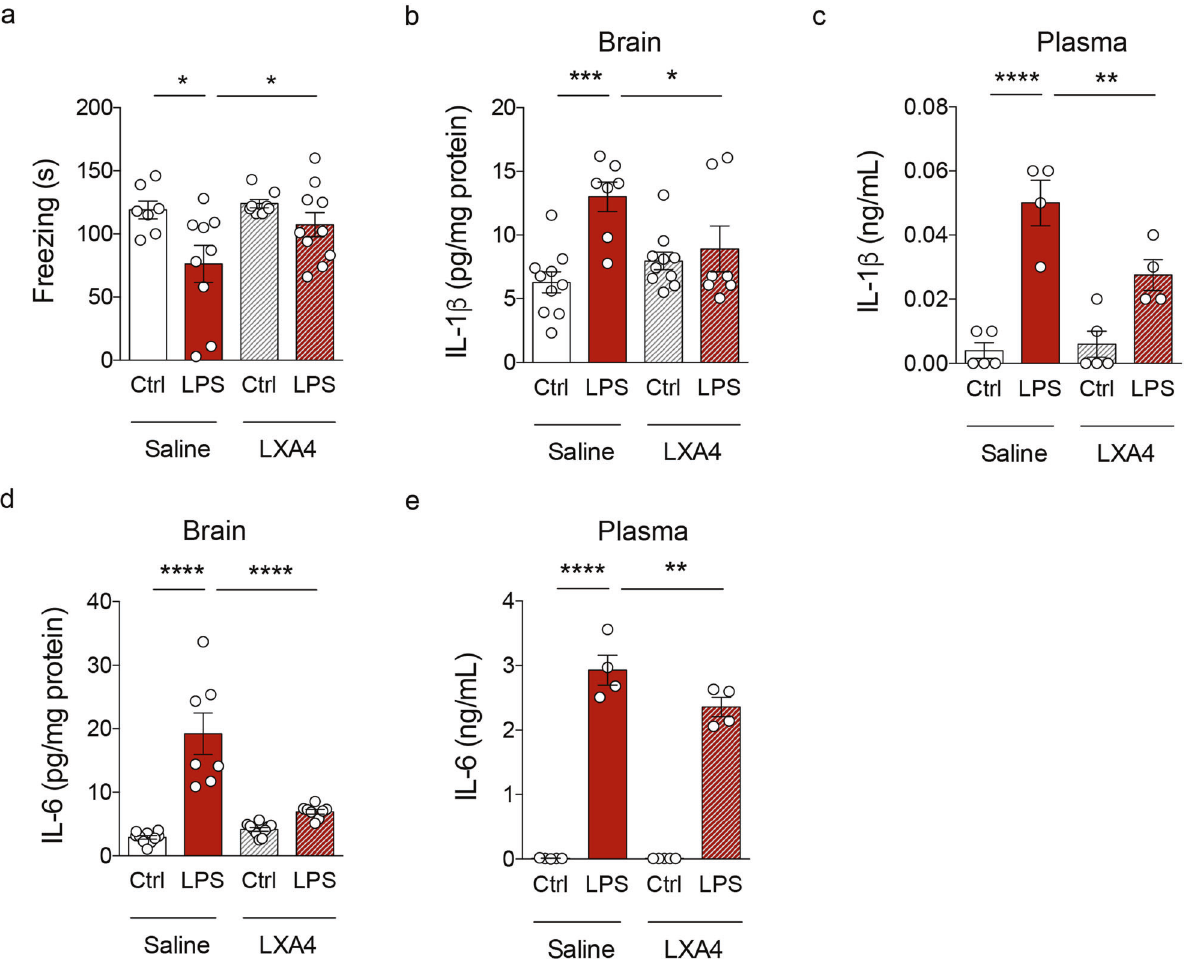
Fig. 3 LXA4 attenuates in fl ammation-induced memory failure and cytokine production in mice. a Freezing (seconds) of control or LPS- injected mice (0.3 mg/kg) treated with vehicle or 1 pmol LXA4 (i.c.v) in the contextual fear conditioning task. b – e Brain and plasma levels of IL-1 β ( b , c ) or IL-6 ( d , e ) in control or LPS-injected mice (0.3 mg/kg; i.p.) treated with vehicle or 1 pmol LXA4 (i.c.v). Two-tailed unpaired two-way ANOVA followed by Holm – Š idák post hoc test (* p < 0.05; ** p < 0.01; *** p < 0.001; **** p < 0.0001). Graphs show means ± standard error of the mean